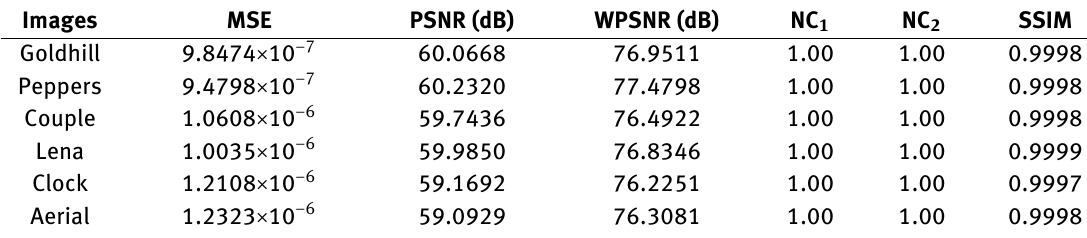
Table 1: Performance Metrics for Proposed Technique under No Attacks.